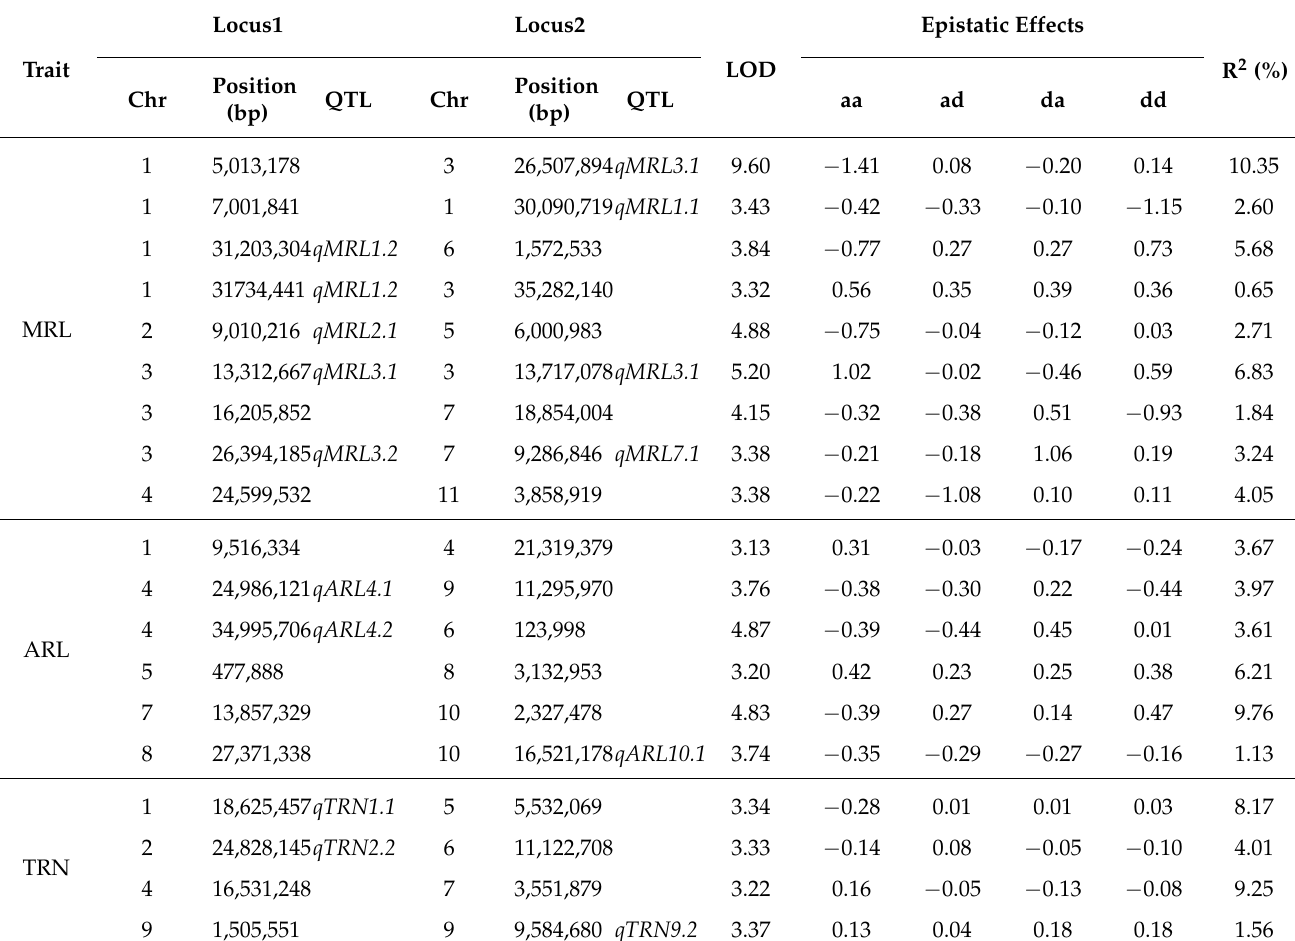
Table 3. Significant epistasis loci of MRL, ARL, and TRN in 391 rice